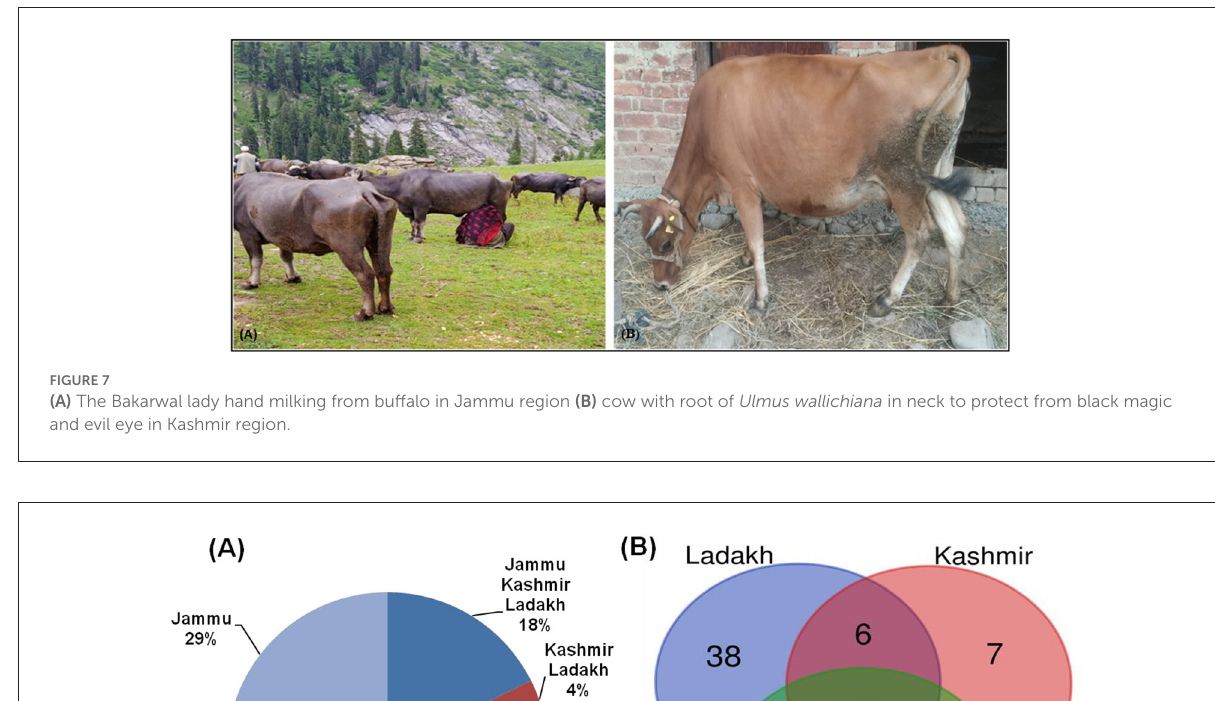
Seasonal usage of plant